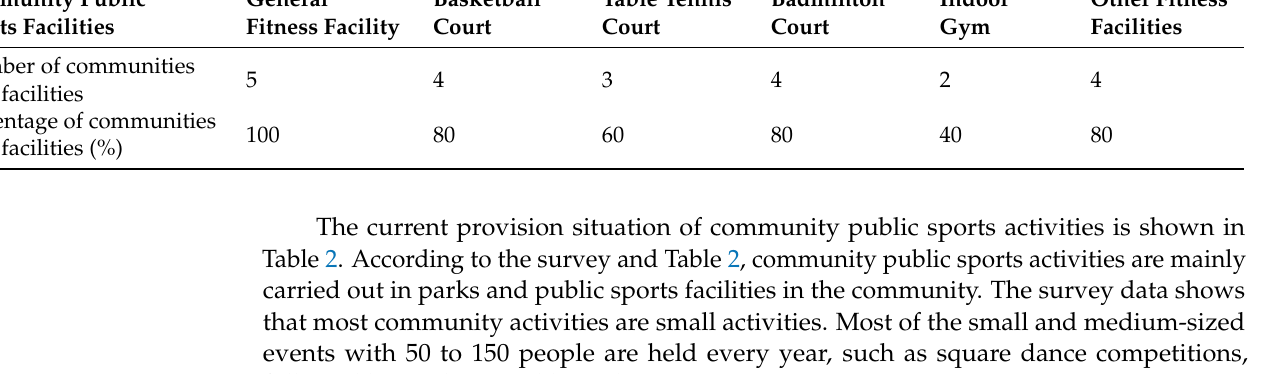
Table 1. Current status of supply of community public sports facilities.